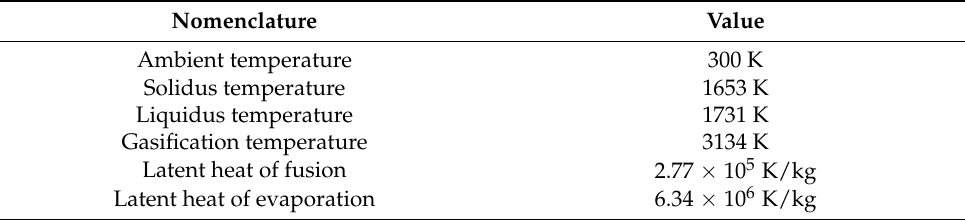
Table 5. Thermophysical parameters assumed in the computer simulations.